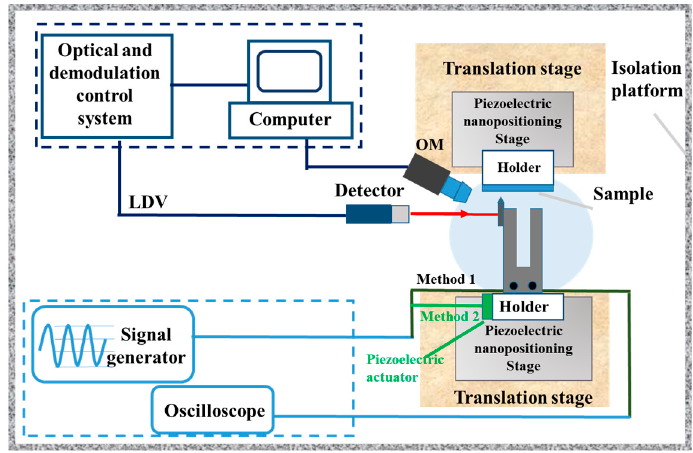
Figure 2. Schematic of the QTF testing system. Four parts are included: QTF-exciting unit, amplitude- frequency measurement unit, microscope and displacement control unit.